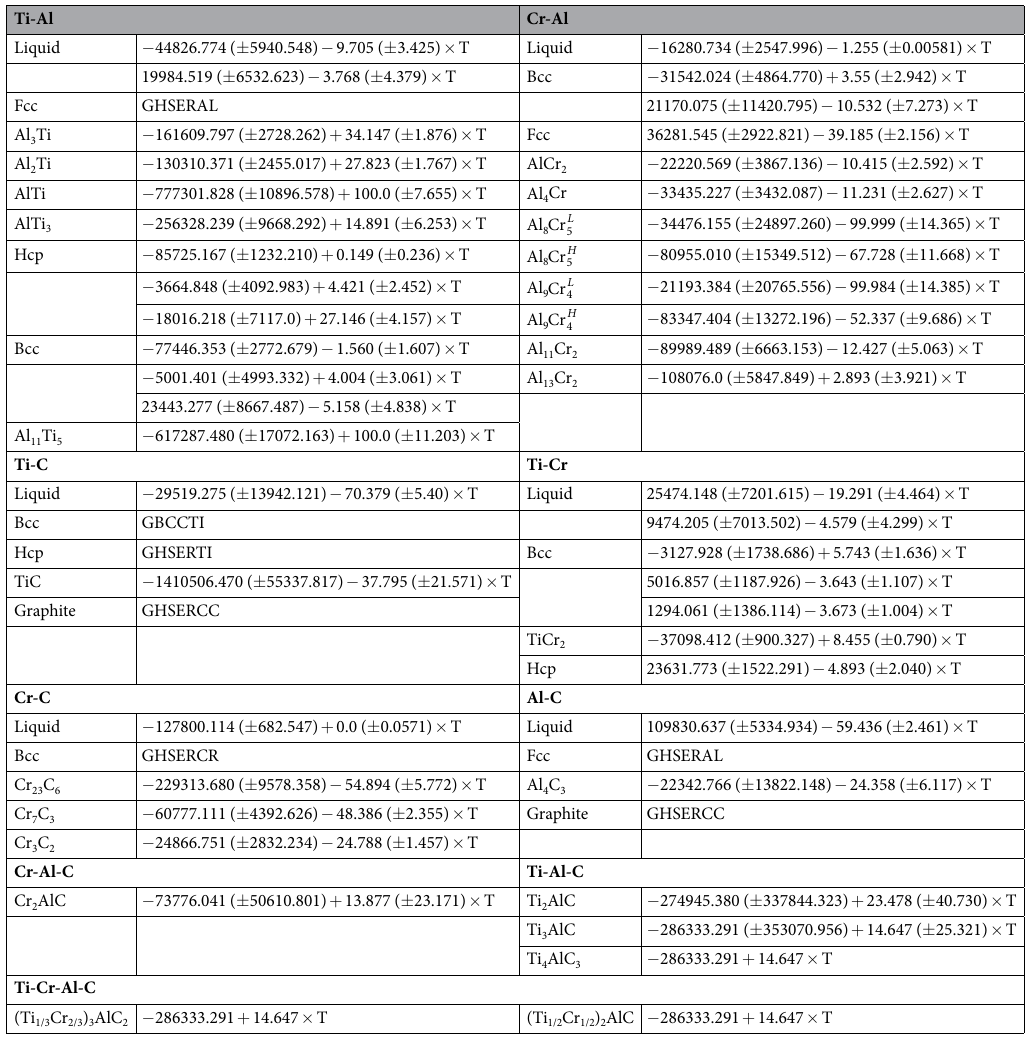
Table 3. Optimized CALPHAD parameters and their (Bayesian) standard deviations of the binaries, ternaries, and quaternary. Note that (1) the energies resulted from these parameters are in the typical unit of J / mol / atom and (2) the standard deviations of Cr-Al-C and Ti-Al-C are relatively large due to the fact that there are much fewer thermodynamic constraints available for these systems than the